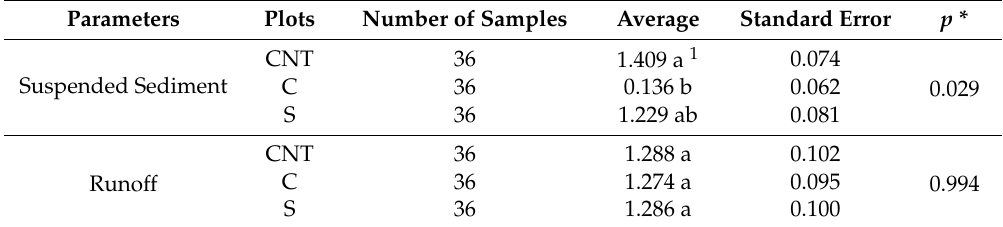
Table 3. Variance analysis results for transported suspended sediment.